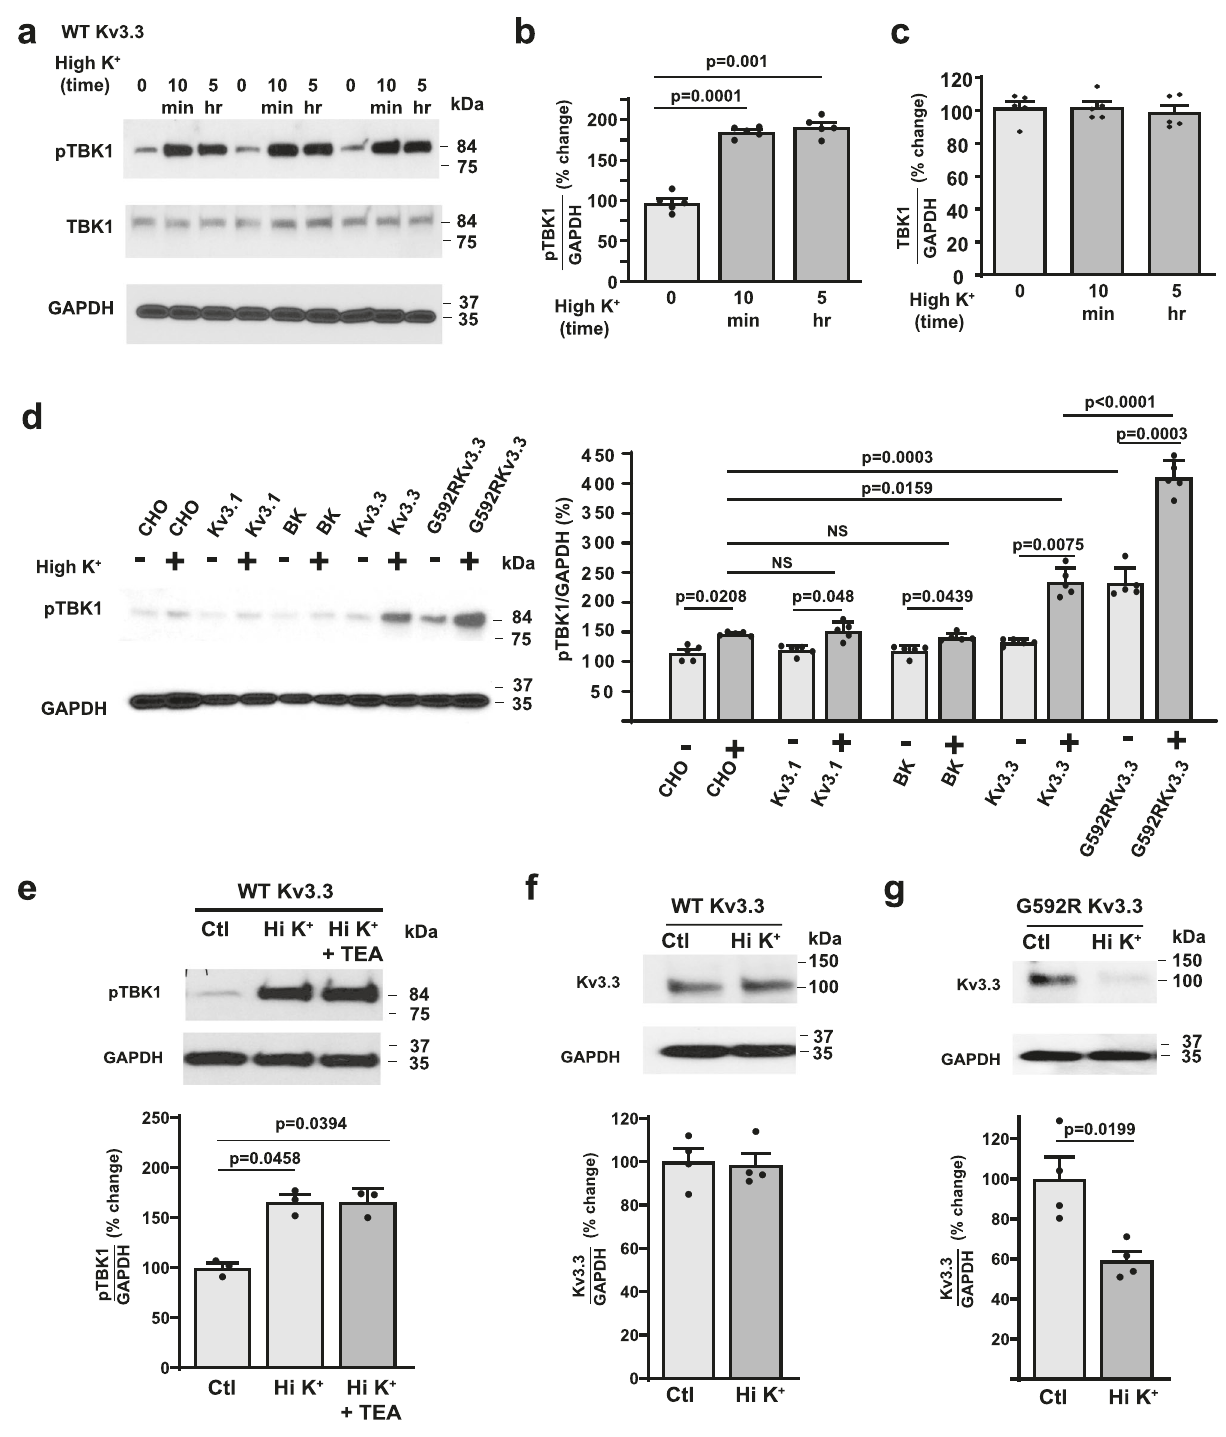
(Fig. 5c, right panel, green asterisks ). A proportion of the cells expressing the mutant channels, however, exhibited a very dense pattern of staining. These cells were also conspicuous by being surrounded by numerous small deposits of Hax-1-stained extra- cellular structures (Fig. 5c, left panel, red arrows ). The densely stained cells represented ~8 – 9% of the population of cells (Fig. 5h). Immuno-EM revealed that, in the densely stained G592R Kv3.3 expressing cells, Hax-1 is present in undigested inclusions within large late endosomal/lysosomal structures (Fig. 5f).